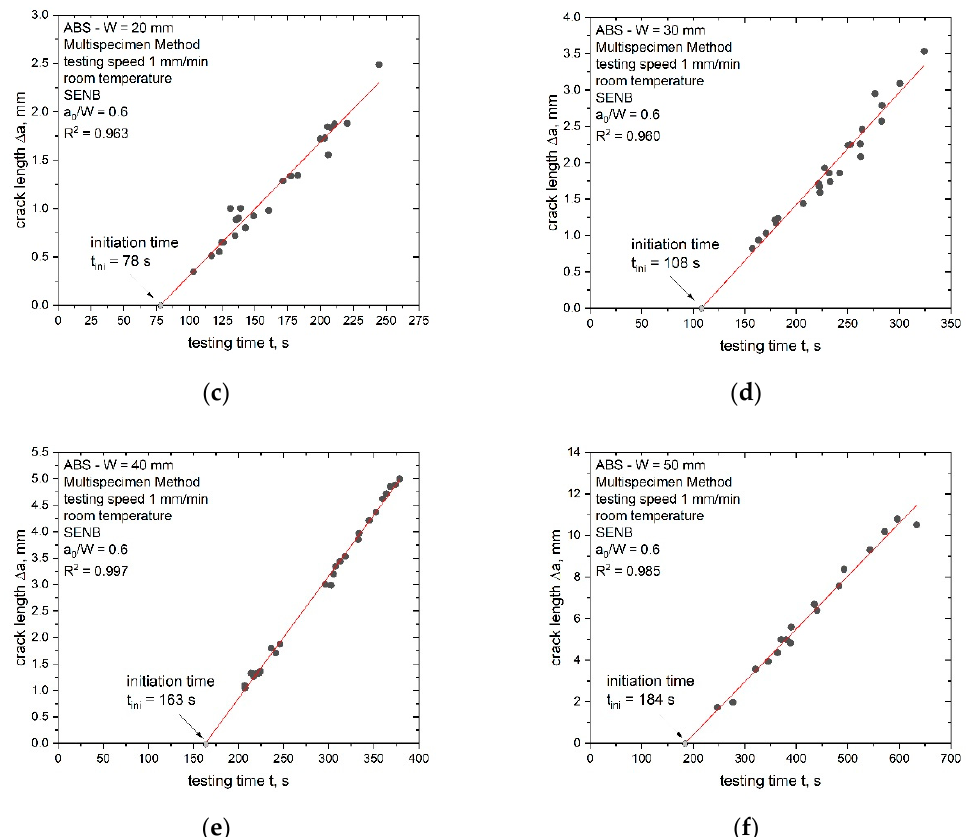
Figure 13. Determination of the crack initiation time, t ini , via the crack propagation kinetics curve (produced crack length Δ a (black dots) depending on the testing time, t) for all investigated specimen sizes of ABS (W of 5 ( a ), 10 ( b ), 20 ( c ), 30 ( d ), 40 ( e ) and 50 mm ( f )).